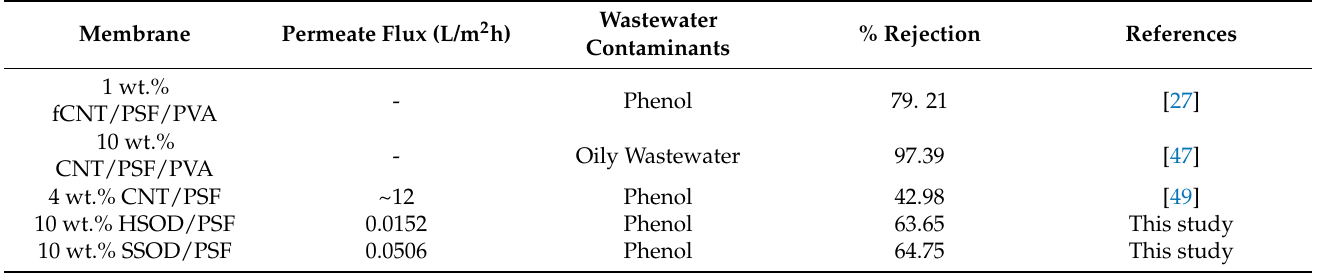
Table 2. The comparison of the performance between HSOD/PSF and SSOD/PSF and literature. Membrane